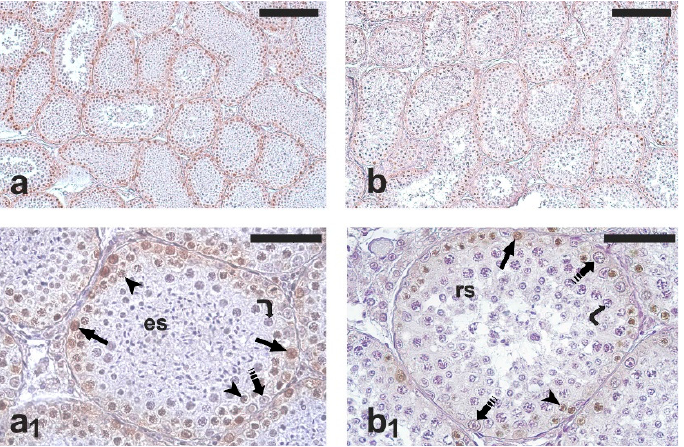
Figure 1. Micrographs of testis sections from cats orchiectomized during the reproductive (left) and non-reproductive period (right) that were immunostained with antibodies against proliferating cell nuclear antigen (PCNA). Dividing germ cells, stained in brown, are localized in the peripheral region of seminiferous tubules. ( a , b ) Low-magnification micrographs showing the general pattern of anti-PCNA immunostaining. ( a 1 ) Cross-section of a seminiferous tubule containing spermatogonia, spermatocytes, and elongated spermatids—a germ cell composition corresponding to the middle stage group (spermatogenic stages VI–VIII) of Xu et al. (2021) [2]. ( b 1 ) Cross-section of a seminiferous tubule containing spermatogonia, spermatocytes, and rounded spermatids—a germ cell composition corresponding to the early stage group (spermatogenic stages I–V) of Xu et al. (2021) [2]. A higher number of PCNA-positive cells is visible in (a 1 ) and in (b 1 ). Arrow, PCNA-positive spermatogonium; dashed arrow, PCNA-negative spermatogonium; arrowhead, PCNA-positive spermatocyte; curved arrow, PCNA-negative spermatocyte; es, elongated spermatids; rs, round spermatids. Scale bars = 200 μ m in ( a , b ) and 50 μ m in ( a 1 , b 1 ).